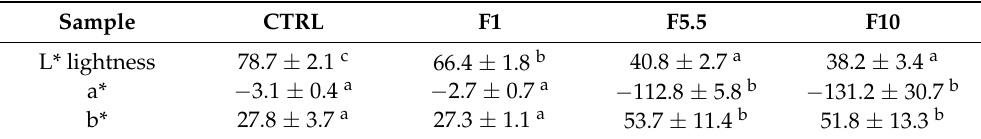
Table 3. Color parameters (L*, a*, b*) of uncooked semolina pasta (CTRL) and pasta enriched with F. vesiculosus (F1, F5,